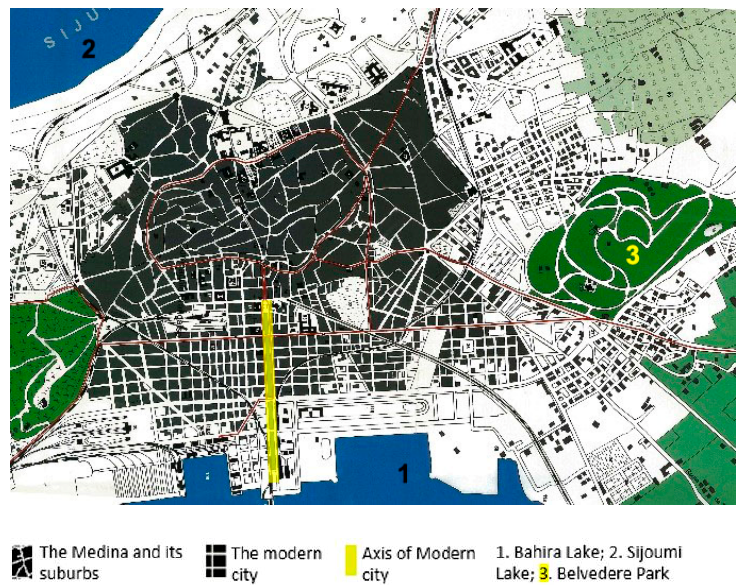
Figure 5. The Medina of Tunis and the Modern city development along an urban axis that starts from the Medina, in 1930 (adapted data source: Ammar, L. Les enjeux du patrimoine ancien et récent à Tunis aux XIXe et XXe siècles. Al-Sabîl: Revue d’Histoire, d’Archéologie et d’Architecture Maghrébines, 2017, 03).